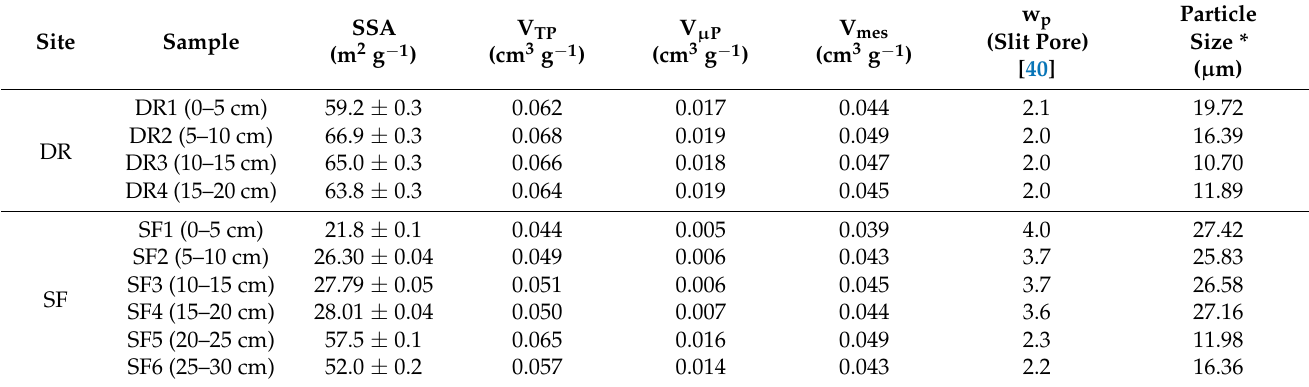
Table 3. Particle size, surface (SSA), and textural properties (V TP ; V µ P ; V mes , and w p ) of the sediments collected at the DR and SF sites in Reconquista